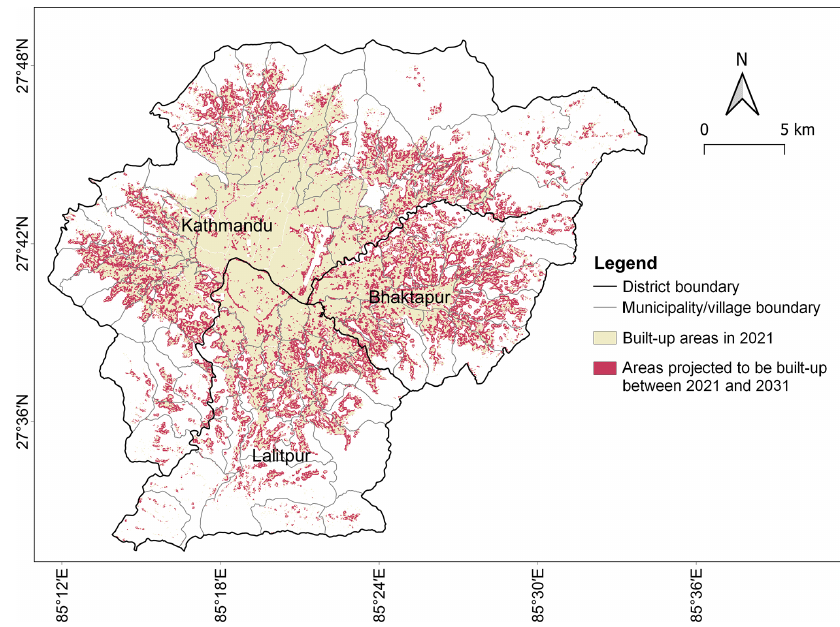
Figure 2. Administrative map of Kathmandu Valley and its built-up areas (Mesta et al., 2022b).